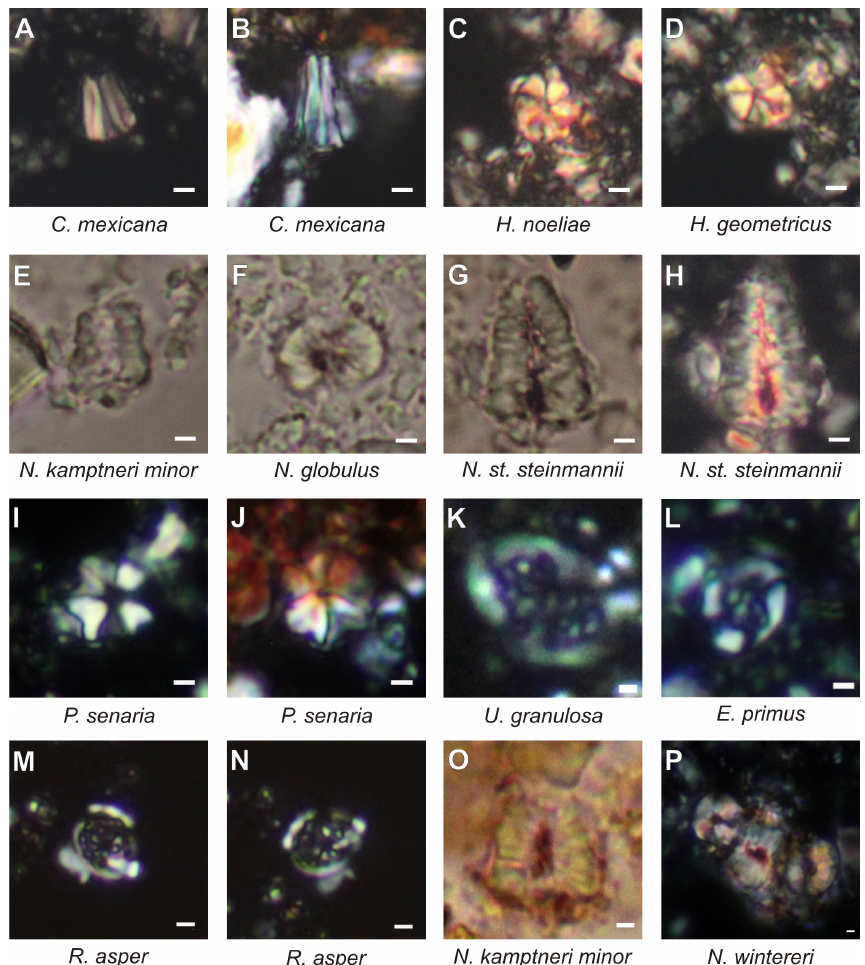
Figure 3. (a–h) Representative calcareous nannofossils from the Mazatepec section, Mexico. (a) Conusphaera mexicana Trejo (BAFC- NP 4190) (2m), (b) Conusphaera mexicana Trejo (BAFC-NP 4196) (11m), (c) Hexalithus noeliae Loeblich and Tappan (BAFC-NP 4195) (7.5m), (d) Hexalithus geometricus Casellato (BAFC-NP 4205) (25m), (e) Nannoconus kamptneri minor Bralower (BAFC-NP 4201) (16m), (f) Nannoconus globulus Brönnimann (BAFC-NP 4205) (25m), (g–h) Nannoconus steinmannii subsp. steinmannii Kamptner (BAFC-NP 4205) (25m). Our suggestion is to eliminate calcareous nannofossil images published previously from the Las Loicas section in order